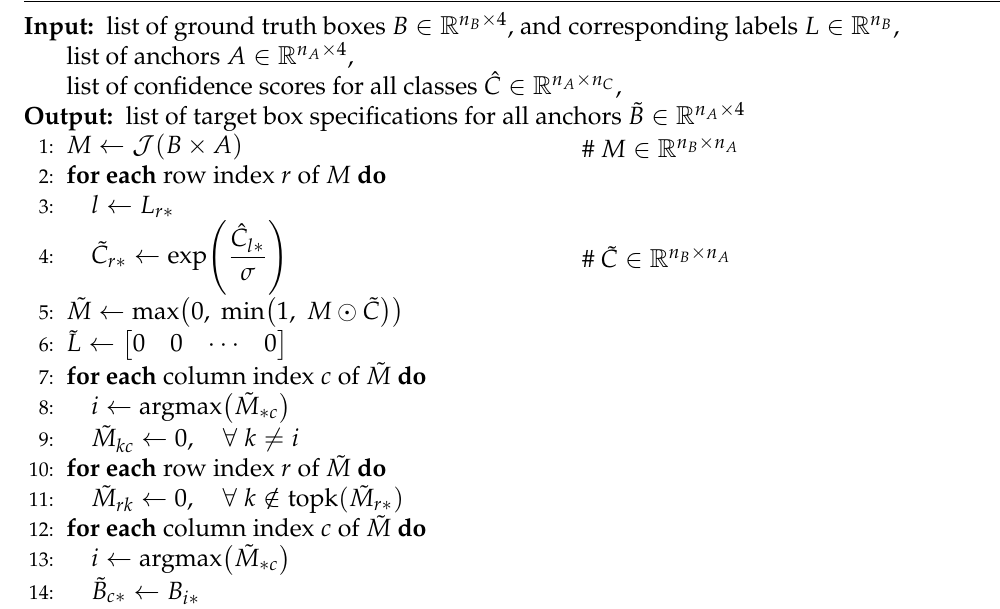
Algorithm 3 Generating localization targets from predicted class